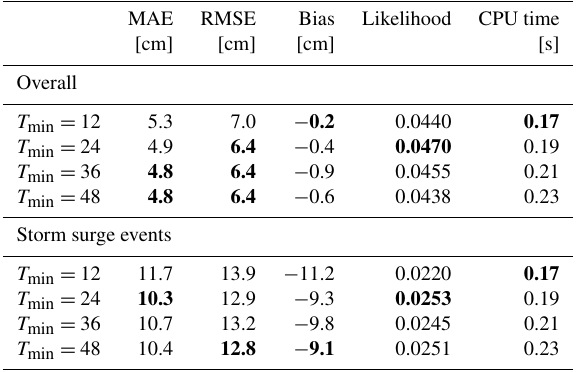
Table 1. HIDRA performance for different historic horizons in terms of mean absolute error (MAE), root mean square error (RMSE), model bias and likelihood shown separately on all data and on storm surge events. CPU execution time (on a single core) per example is also reported. The best result in each category is de- noted in bold.